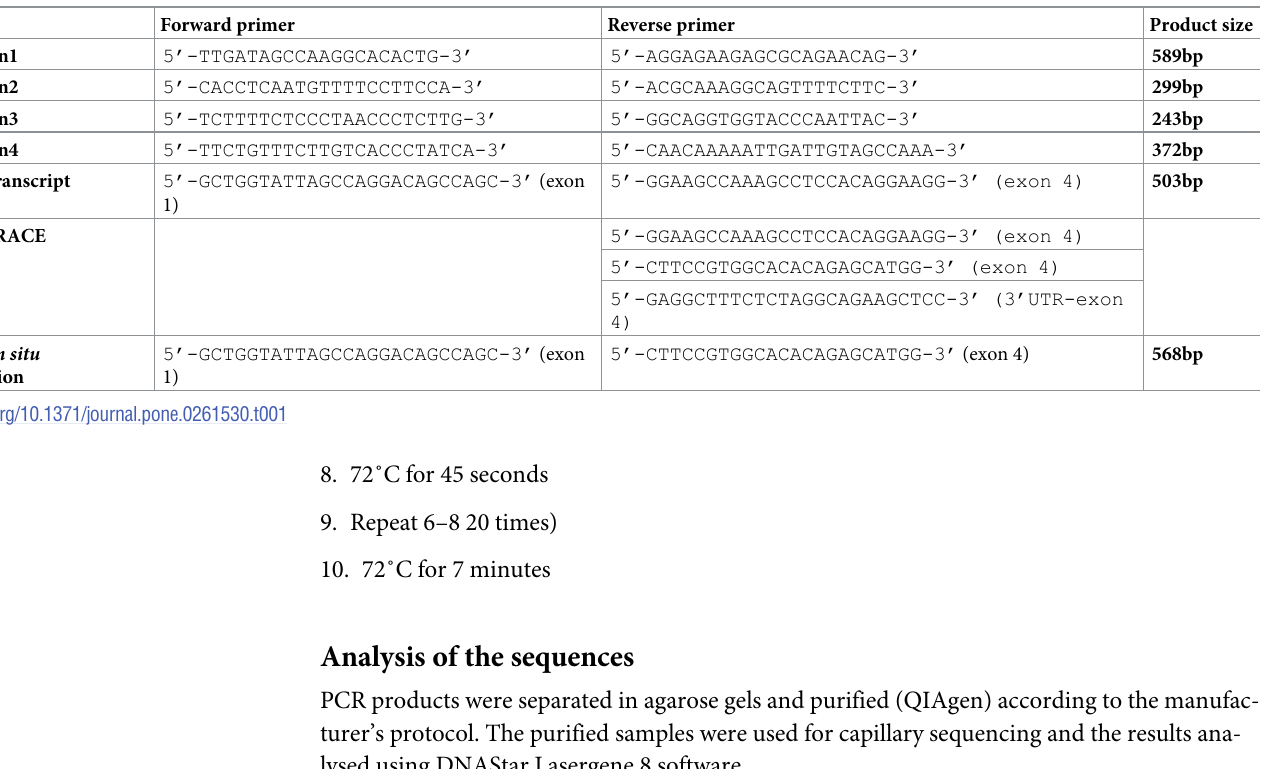
Table 1. List of primers for amplification of Grxcr1 by